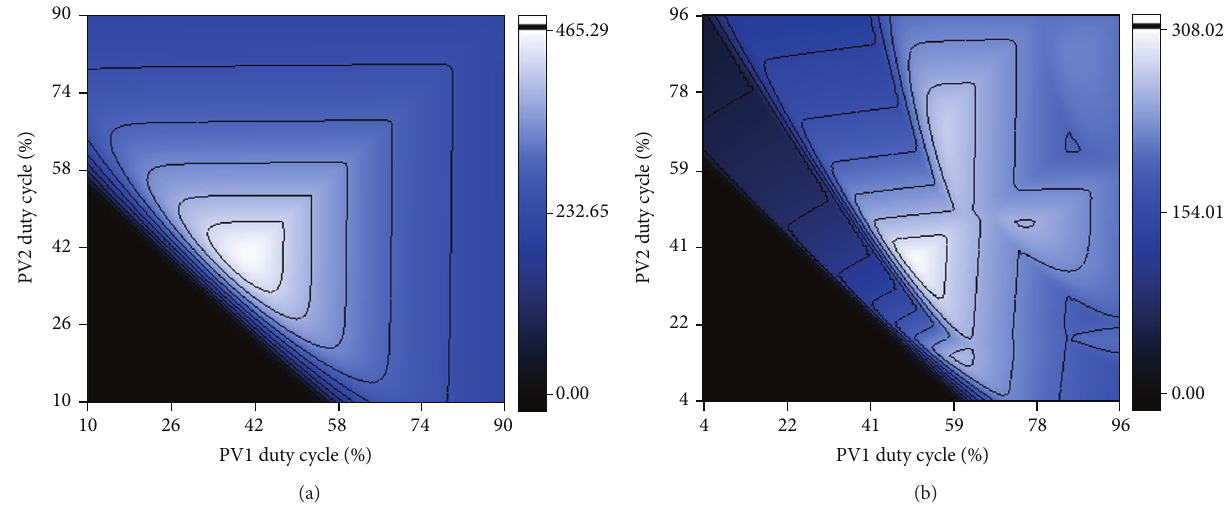
Figure 7: Power contour of the distributed PV system having two modules in series connection; (a) operation in standard test condition; (b) PV panels are partial shaded as described in Figure 6.